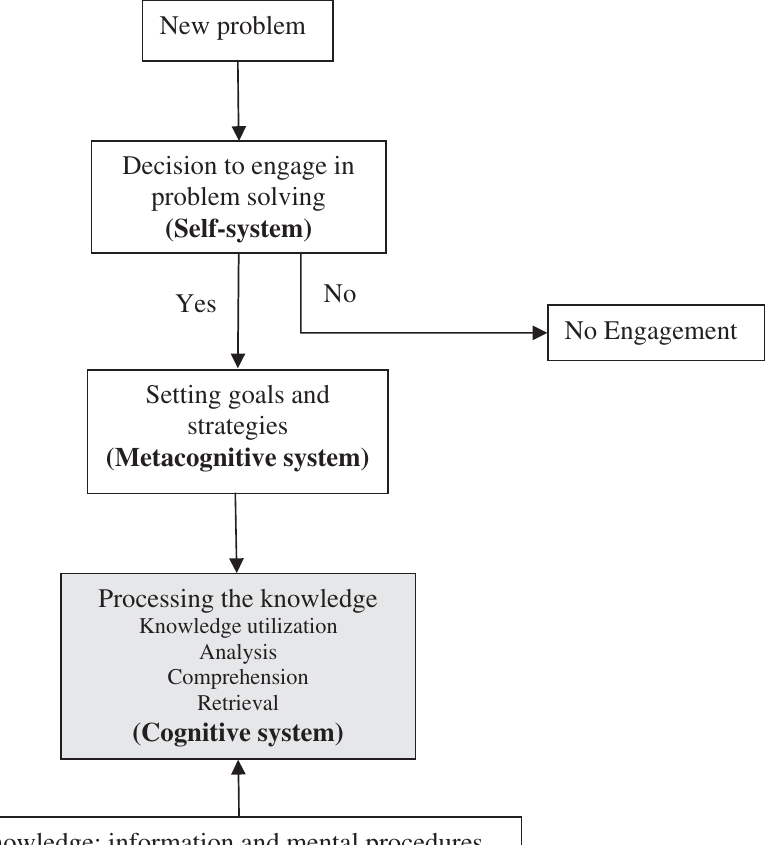
FIG. 1. Schematic diagram of the model of behavior implied in NTEO [26]. Note that TIPP currently only focuses on the interaction between the cognitive system and the knowledge. Reproduced from Ref. [26] with